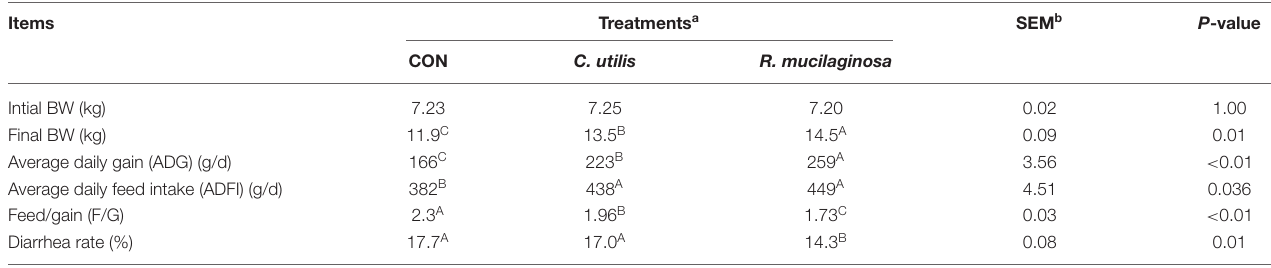
TABLE 5 | Effects of C. utilis DSM 2361 and R. mucilaginosa TZR 2014 on the growth performance and diarrhea incidence in weaned piglets ( n = 10).